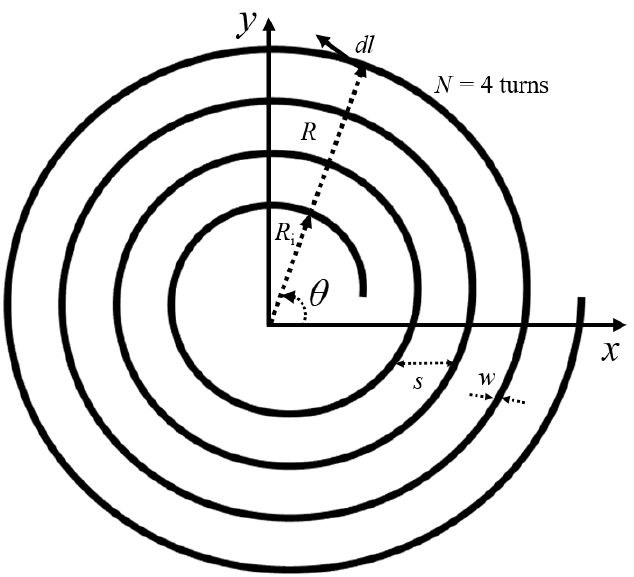
Figure 1. Planar Spiral